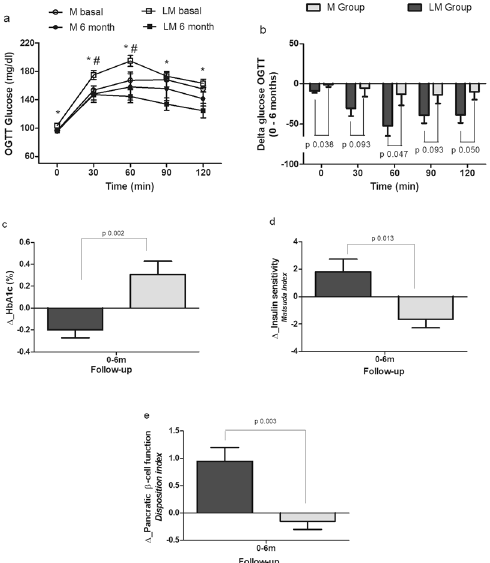
Figure 2. Glucose levels during OGTT at basal and after 6 months ( a ); change in glucose levels ( b ), HbA1c ( c ), insulin sensitivity ( d ), and pancreatic β-cell function ( e ) from 0 to 6 months between the study groups. * p ˂ 0.05 for comparisons in LM group between basal and 6 months, # p ˂ 0.05 for inter-group comparisons at basal (0